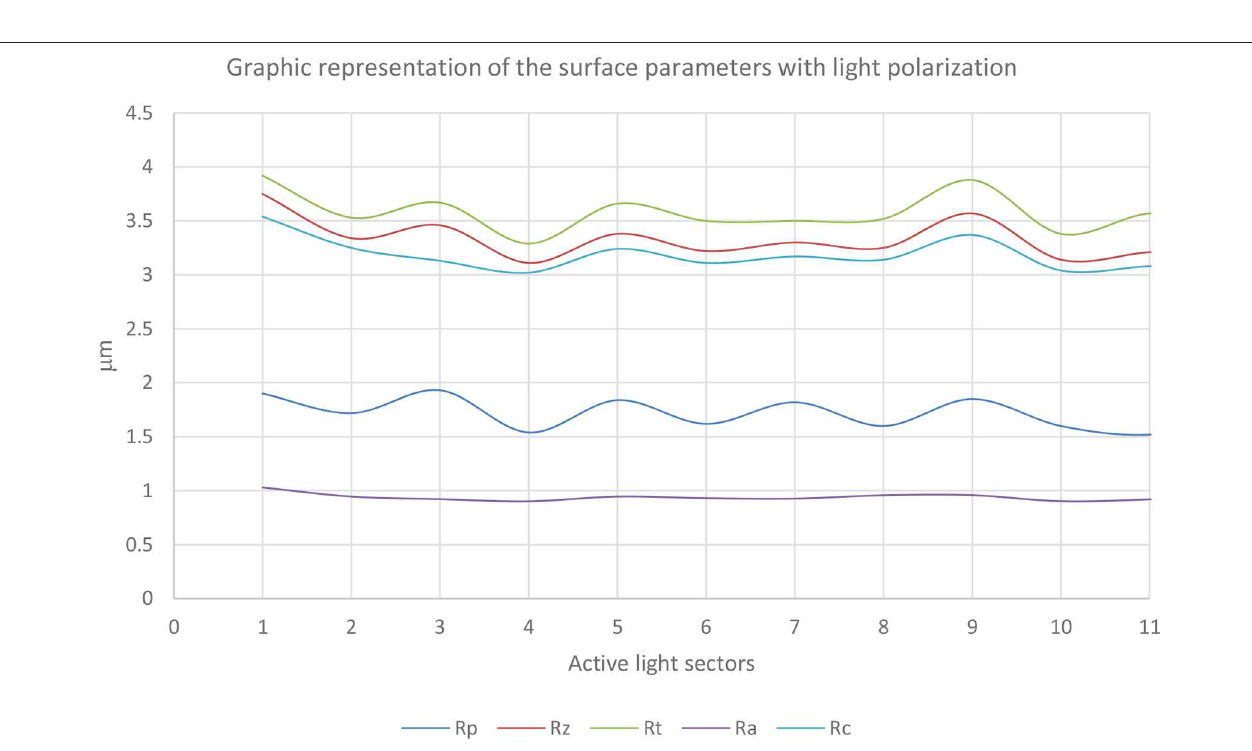
Frontiers in Mechanical Engineering |